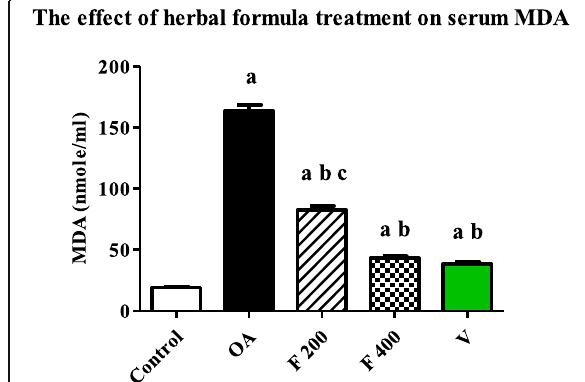
Fig. 4 Serum level of MDA (nmole/ml) in the experimental groups. Herbal formula treatment decreased serum level of MDA in the osteoarthritic rats at the end of 1 month treatment; C = control; OA = osteoarthritis; F 200 = herbal formula 200 mg/kg; F 400 = herbal formula 400 mg/kg; V = Voltaren. Results were expressed as mean ± SEM and analyzed using one-way ANOVA followed by Bonferroni ’ s post hoc test, a = Significant from control at P < 0.0001, b = Significant from OA at P < 0.0001, c = Significant from F 400 at P < 0.0001